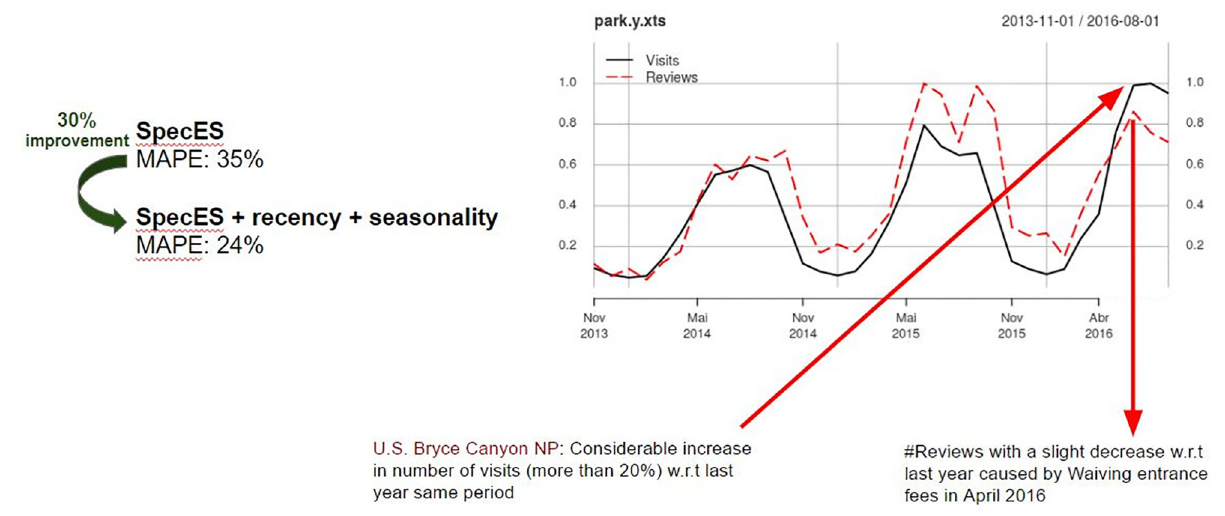
Fig 7. Temporal evolution of number of visits and social media comments in Bryce Canyon National Park in U.S.—significant gain using specialized model with all recency and seasonality features.